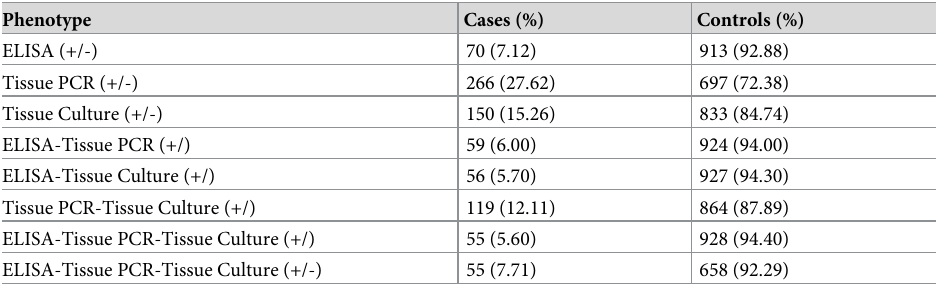
Table 1. Number of cows with a positive and negative test